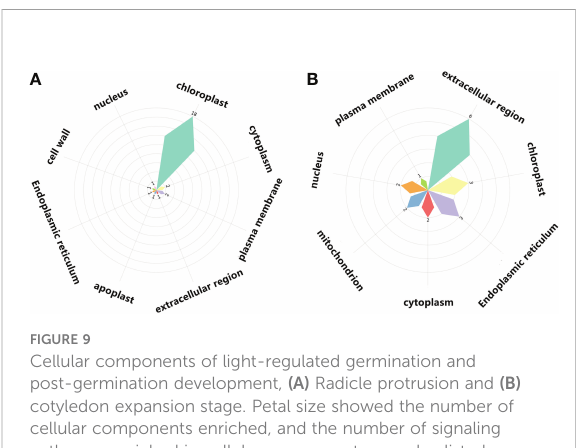
FIGURE 9 Cellular components of light-regulated germination and post-germination development, (A) Radicle protrusion and (B) cotyledon expansion stage. Petal size showed the number of cellular components enriched, and the number of signaling pathways enriched in cellular components was also listed.